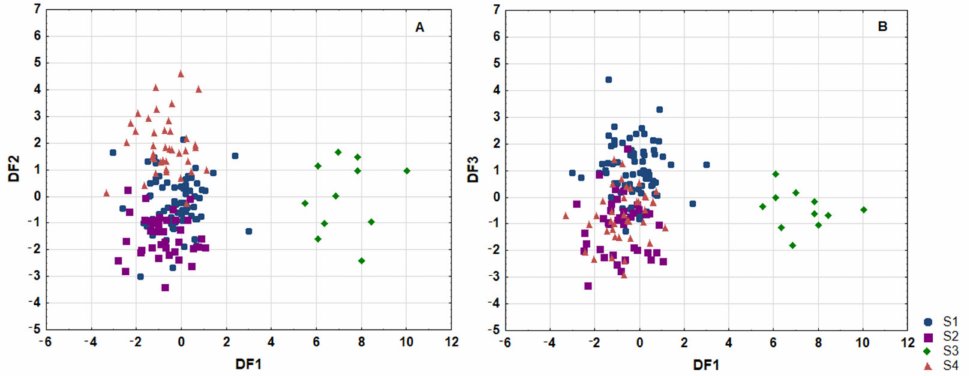
Figure 2. Scatterplot of canonical values for functions DF1 and DF2 ( a ) and DF1 and DF3 ( b ). Sk1–Sk4—distinguished